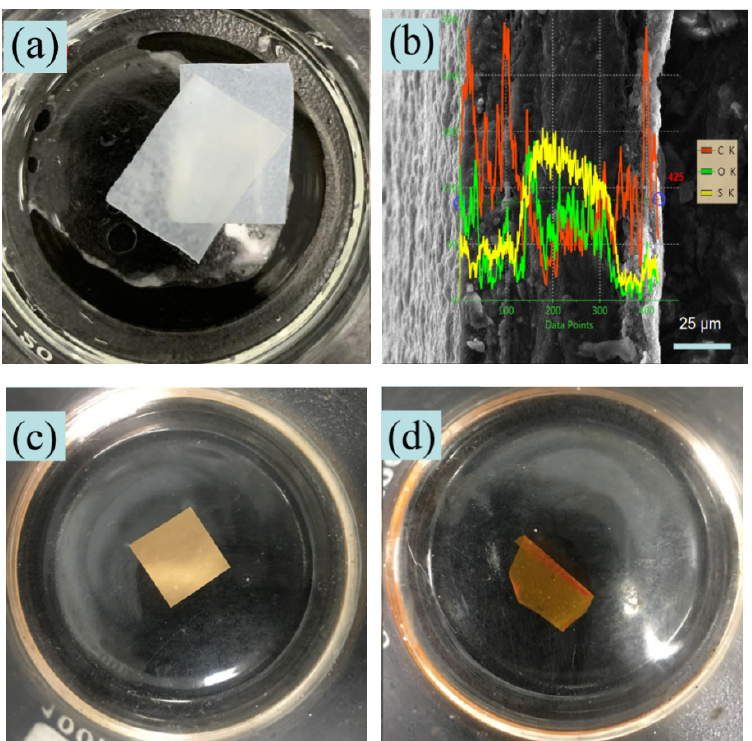
Figure 9. ( a ) Picture of sandwich electrospun PAN:PVP:PAN film, ( b ) EDS result of the sandwich urushiol/PAN: PEDOT:PSS/PVP:urushiol/PAN film, ( c ) picture of the urushiol/PAN:PEDOT: PSS/PVP:urushiol/PAN film immersed in the 80% sulfuric acid solution for 30 min, ( d ) picture of the urushiol/PAN:PEDOT:PSS/PVP:urushiol/PAN film immersed in the 100% sulfuric acid solution for 30 min.